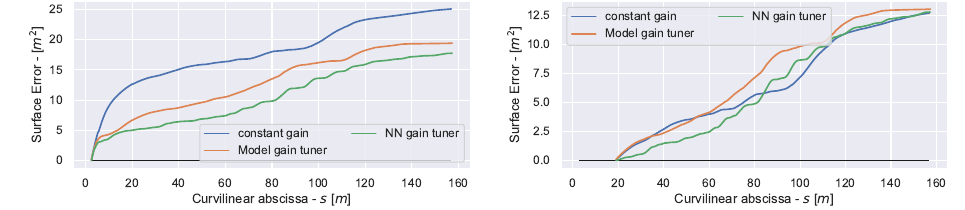
Figure 7. The surface error A error ( left ) and the surface error A error after the initial lateral error ( right ).